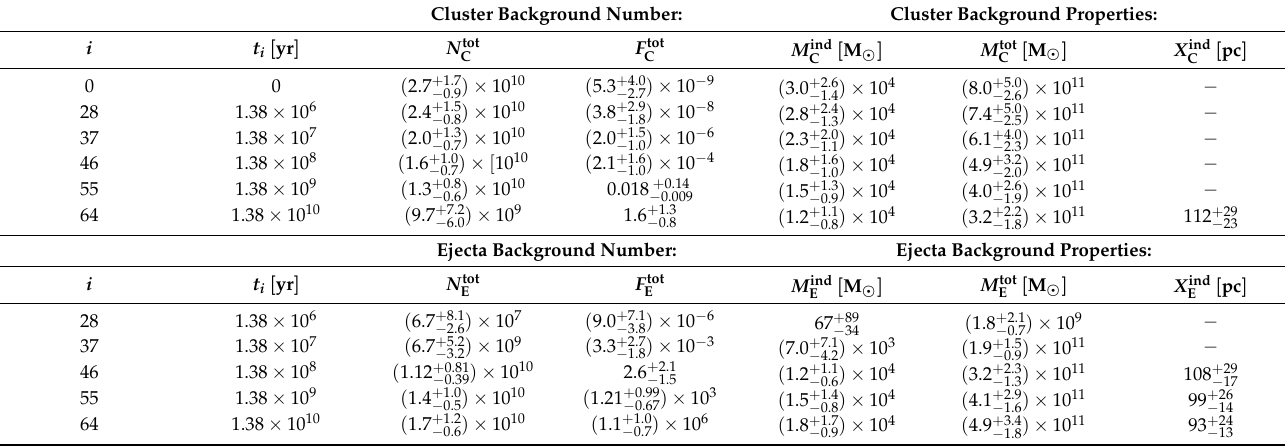
Table 19. Shown are the number of bubbles, N P , segregated by the population (cluster and ejecta) type, in a Milky Way-like galactic halo if all DM is made of PBHs, as well as the volume fraction occupied by the spheres of influence of these bubbles in such galaxy, F P at selected times, and where P = C,E stands for the cluster and ejecta populations. Shown as well are [ M (cid:12) ] , and the total mass of all such bubbles in a milky Way-like galactic halo, the individual masses of such bubbles, M ind P [ M (cid:12) ] . Last, the average distance between individual PBHs in such bubbles, X ind [ pc ] , are shown for the time slices M tot P P in which the bubble’s spheres on influence have undergone sufficient expansion that they start to merge with each other, a point where the volume fraction holds F P ≈